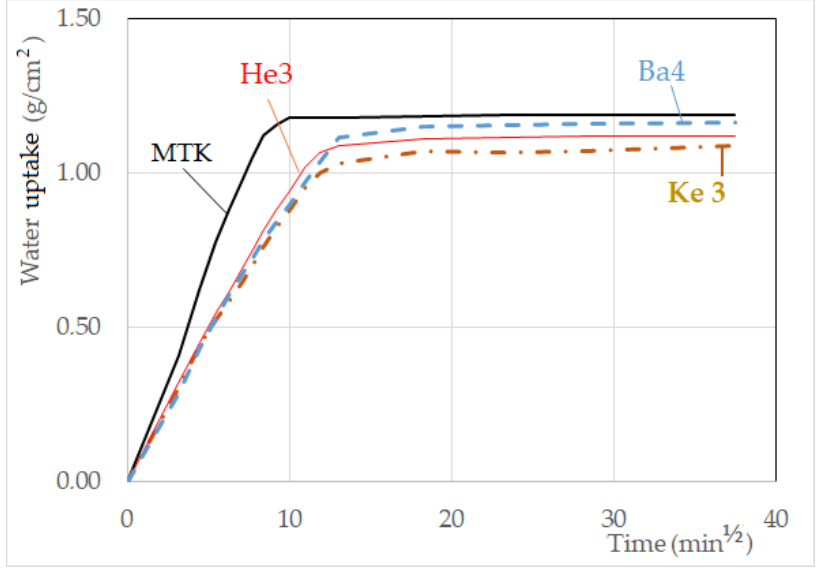
Figure 11. Water uptake of the plain matrix and the samples at the highest amount of fibers.